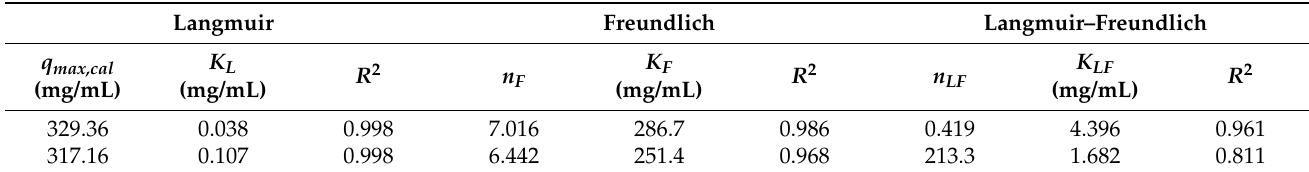
Table 1. Equilibrium and thermodynamic parameters calculated using equilibrium isotherm mod- els for determining the adsorption behavior of P-COOH-CS-CEW nanofiber membrane for AO7 and TBO. Langmuir